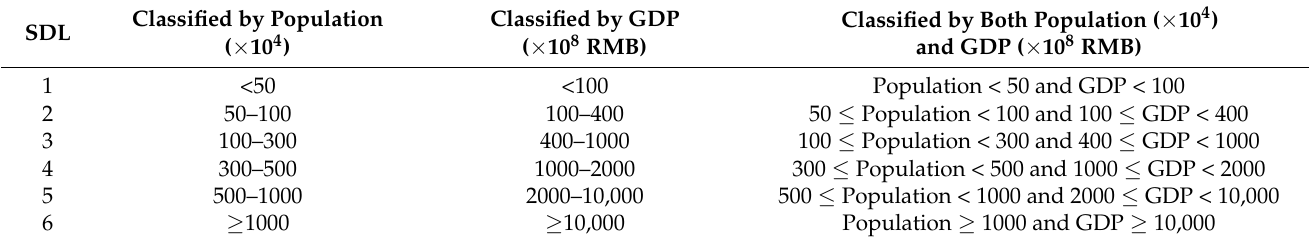
Table 1. SDLs of the selected sites classified by population, GDP, and both. RMB: Chinese